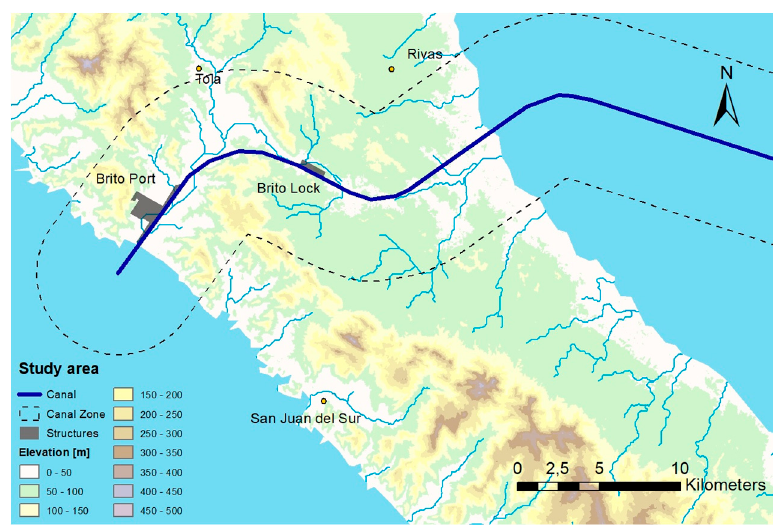
Figure 3. West Canal Segment of the planned Nicaragua Canal (blue line) and the canal zone (dashed line) representing the study area.